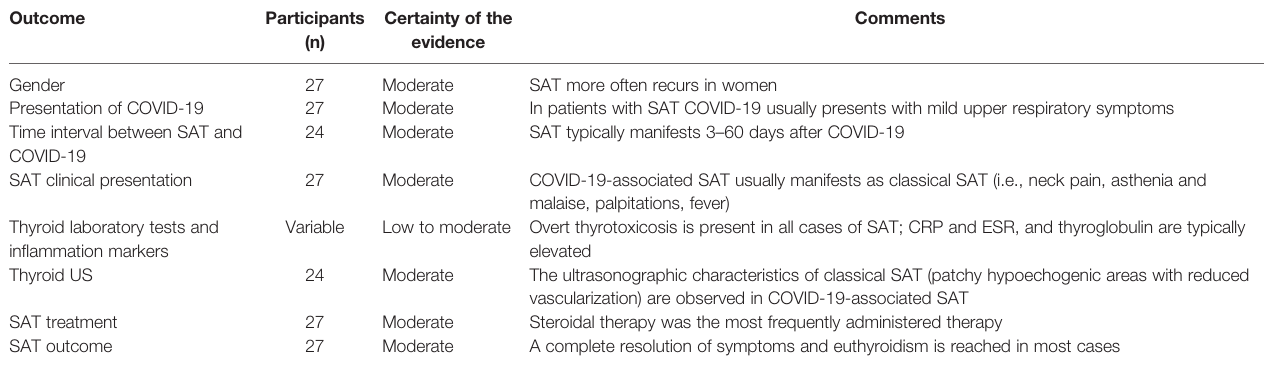
TABLE 4 | Summary of fi ndings about COVID-19-associated